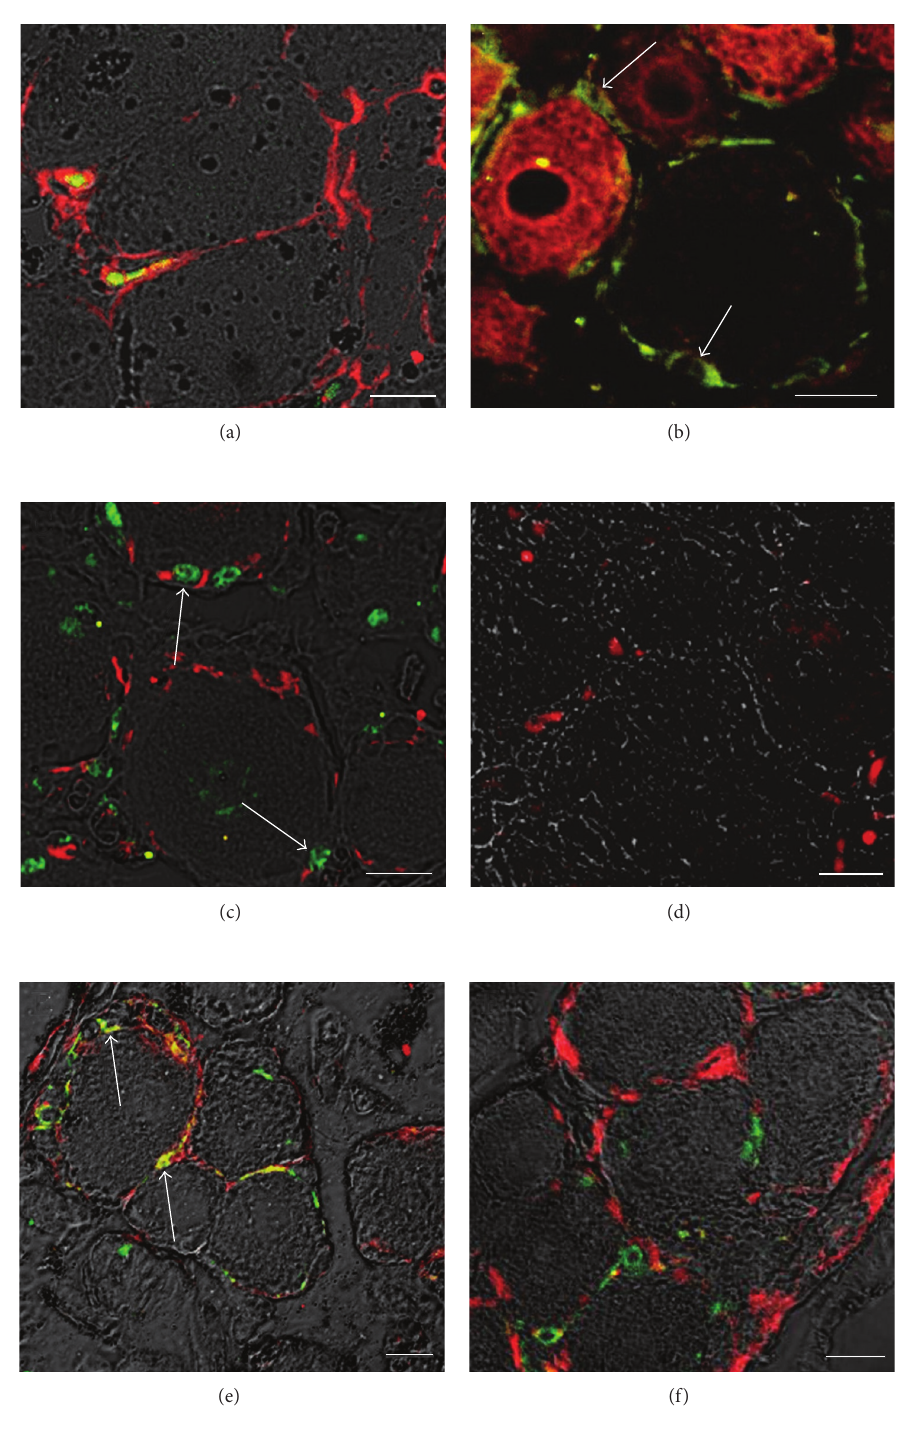
Figure 8: After 3 days from crush lesion, cells coexpressing nanog (red) and Ki67 (green) were found (a). A double immunofluorescence performed at day 5 after injury detects sox-2 positive cells (green) surrounding neurons, some of which are peripherin-positive (red) (b, arrows). At the same time point, the same cells are found coexpressing BrdU (green) and nestin (red) (c, arrows). After 7 days from crush lesion, anti-NeuroD is seen to be expressed in many nuclei surrounding the DRG neurons (d). Further characterization of this cell population was done using markers for both immature and mature glial cells. A double labeling using nestin (green) and the immature glial marker GFAP (red) shows that, at day 5 after injury, the two markers colocalize in some cells (e, arrows). However, no colocalization is observed in double labeling of nestin with S-100 (mature glia, in red) (f). Scale bars: a–f = 20 𝜇